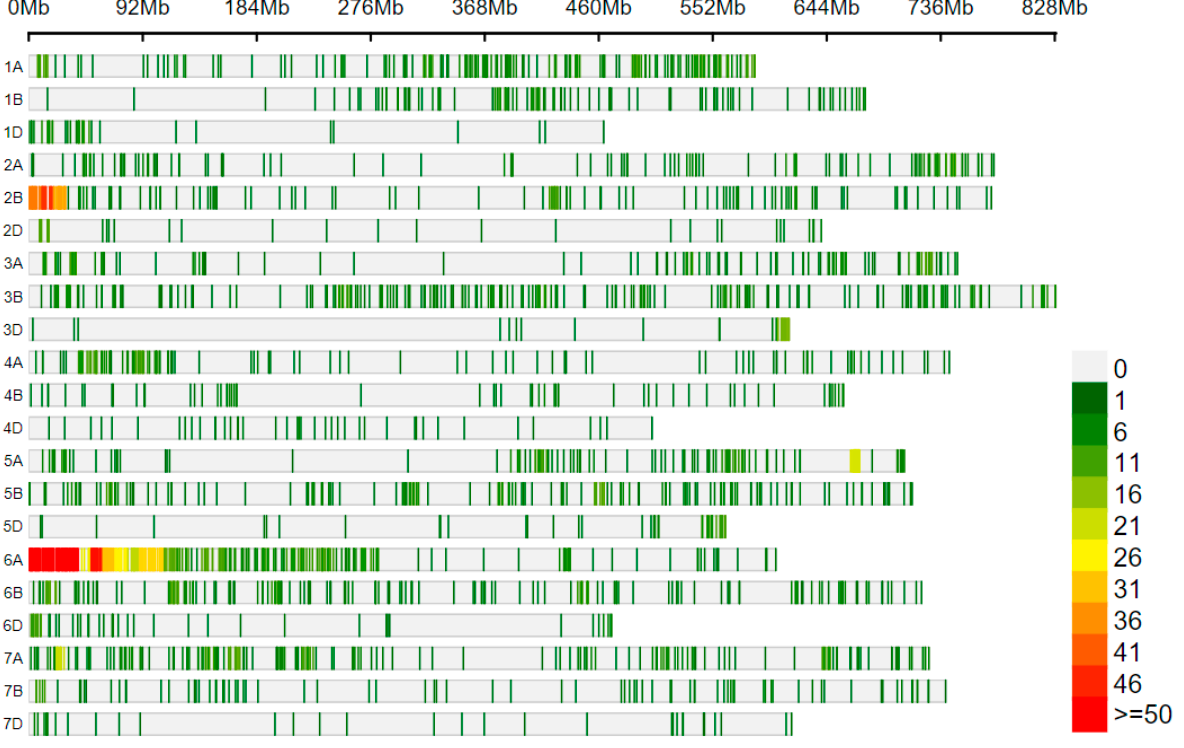
Figure 6. Distribution of SNPs on each chromosome between B303 and Wan7107.